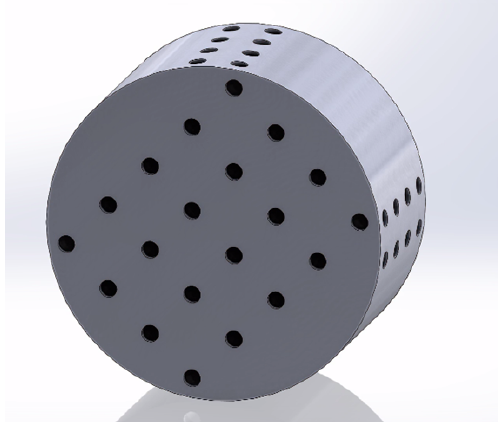
Figure 5. DENORMS block normal incident testing.